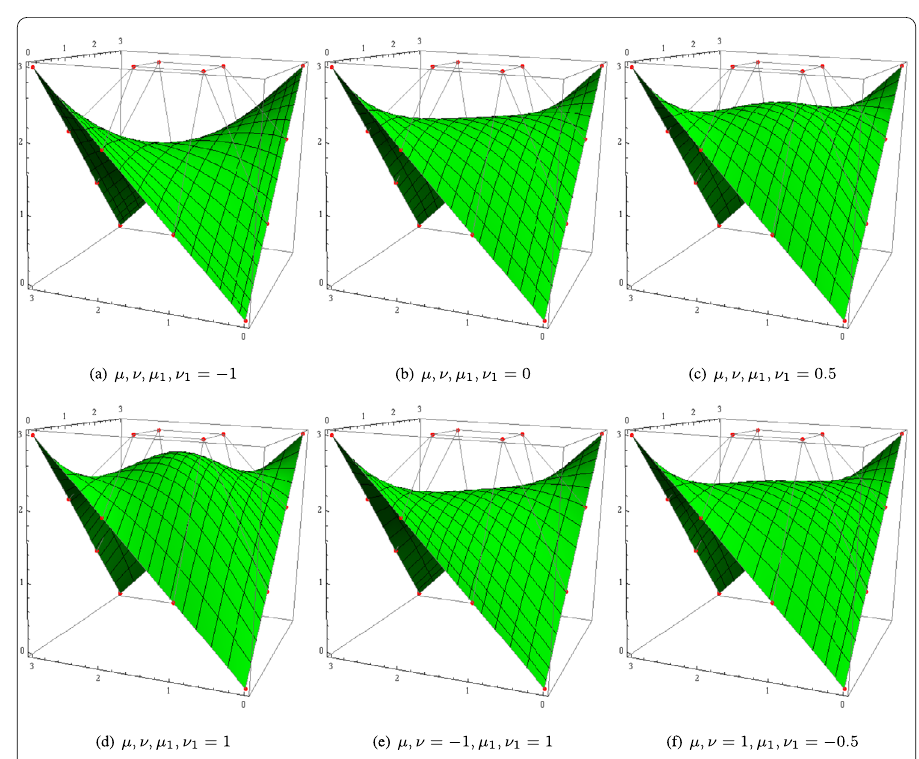
Figure 8 GBT-Bézier bi-linear surfaces with non-planar straight line boundaries